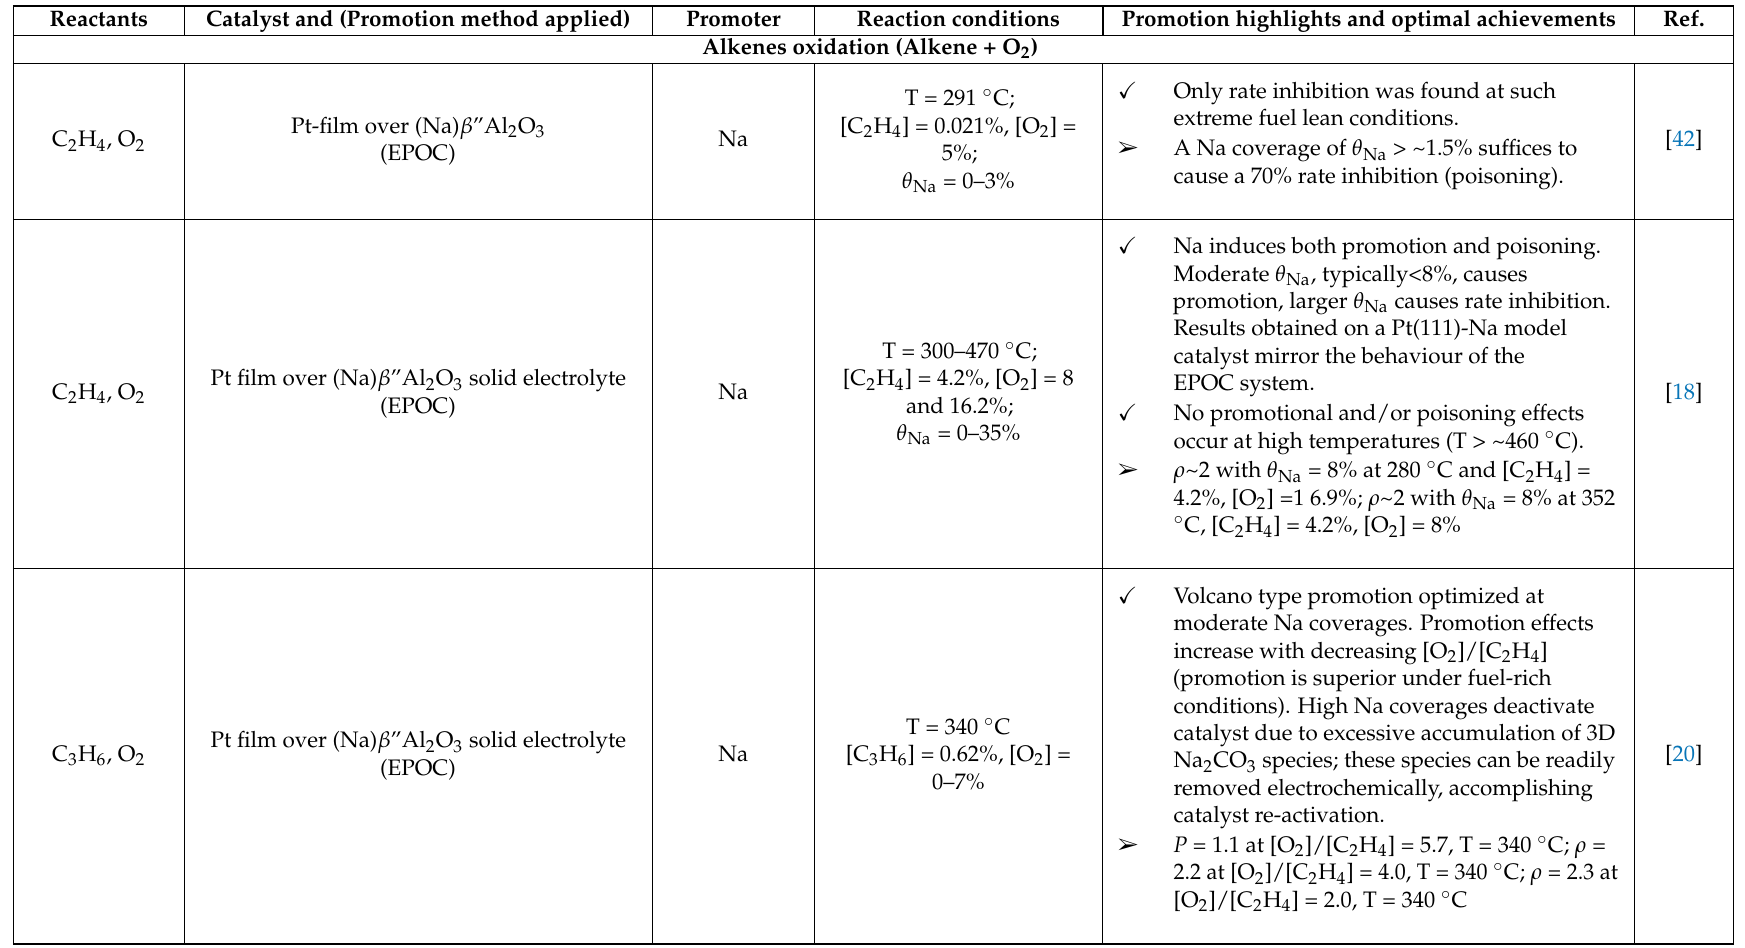
Table 2. Electropositive promotion of PGMs-catalysed alkenes and alkanes